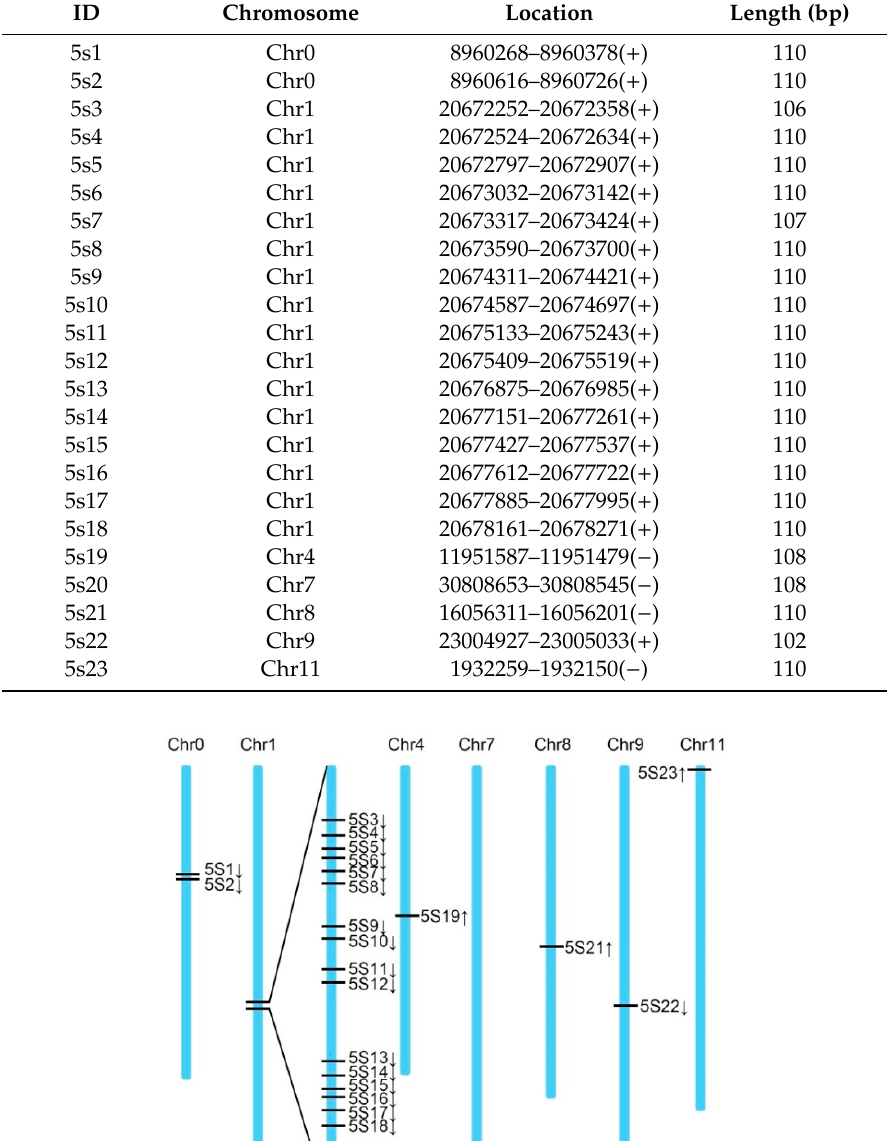
Table 2. 5S rDNA fragment homologous sequence information.